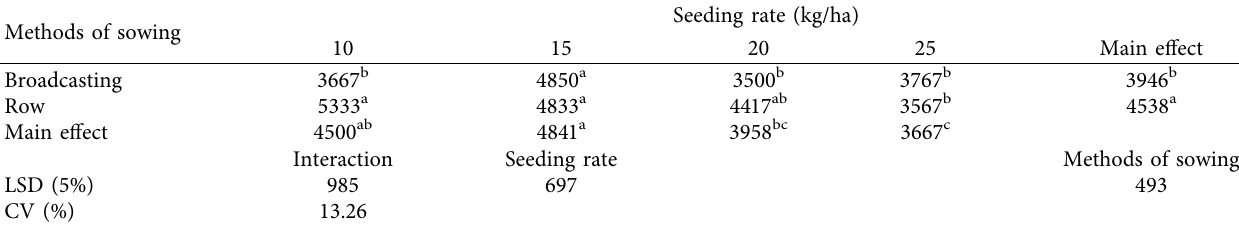
Means with the same superscript letter within a column do not statistically differ at 0.05 probability level according to Fisher’s Table 5: Interaction and main effect of seeding rate and methods of sowing on straw yield of teff (kg/ha). Methods of sowing